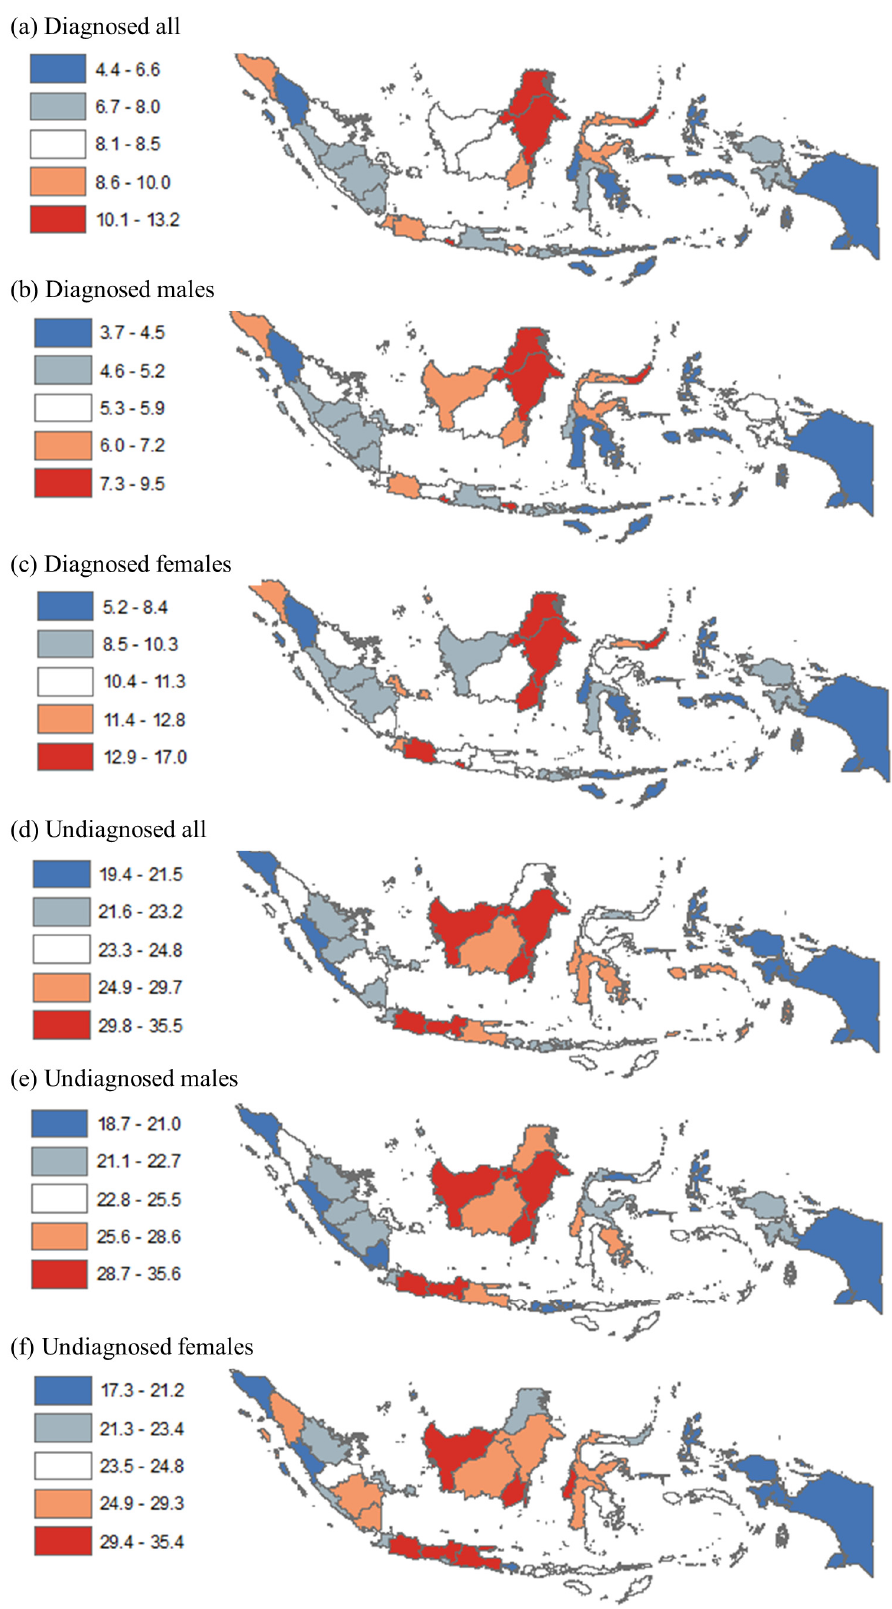
Figure 1. Disparity in diagnosed and undiagnosed hypertension among adults (18+ years) by province in Indonesia, 2018. Note: Numbers show prevalence of diagnosed and undiagnosed hypertension among all adults, males, and